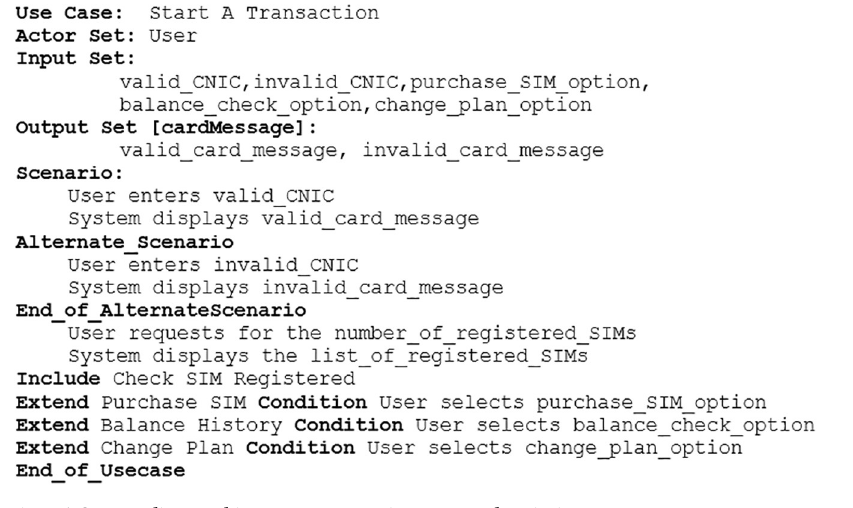
Fig 8. A SIM vending machine start a transaction use case description.